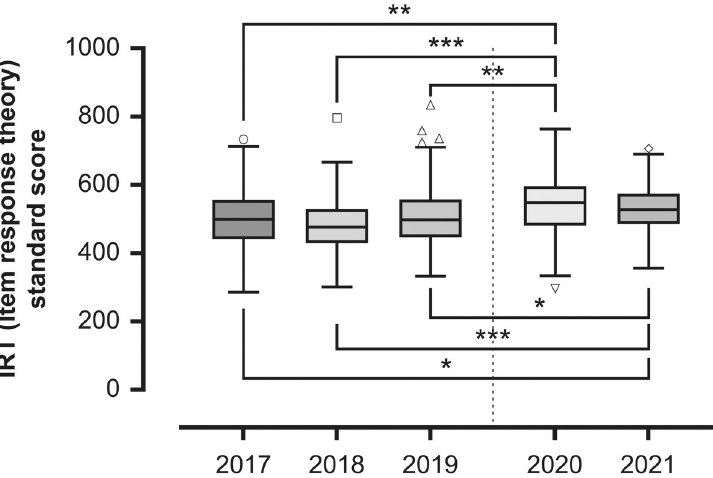
Fig 1. A comparison of IRT standard test scores between 2020 and 2021 and 2017 through 2019. Upper whisker represents maximum observation, lower whisker represents minimum observation, circle symbols represent outliers, upper line of box represents third quartile, middle line of box represents median, lower line of box represents first quartile, and x represents mean. Significance level for � < .05, �� < .01, and ��� < .001.